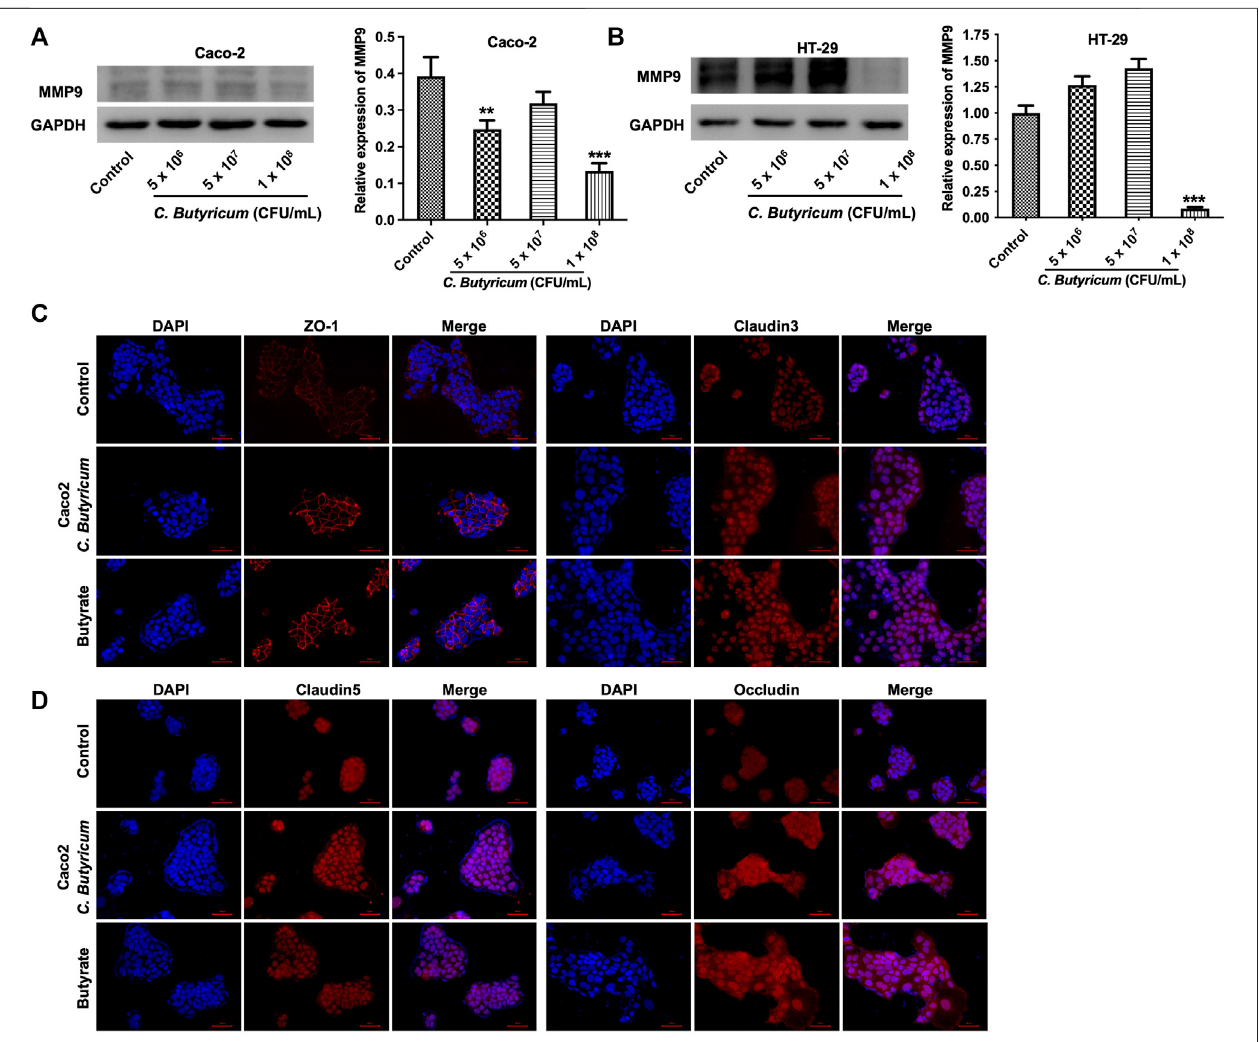
FIGURE 2 | Clostridium butyricum or butyrate treatment reduced MMP9 expression in Caco-2 and HT-29 cells. (A) The Caco-2 and (B) HT-29 cells were co- cultured with (C) butyricum (5 × 10 6 , 5 × 10 7 , or 1 × 10 8 CFU/ml) for 6 h in an anaerobic environment. After that, the supernatant was removed, and cells were then cultured in normoxia environment for 48 h. Western blot assay was used to determine the expression of MMP9 in cells. (C,D) Caco-2 cells were treated with 2 mM butyrate for 48 h. Meanwhile, cells were co-cultured with C. butyricum (1 × 10 8 CFU/ml) for 6 h in an anaerobic environment. After that, the supernatant was removed,and cellswerethencultured innormoxiaenvironment for48 h.IFassaywasusedtodetermine theexpressions ofZO-1, Claudin3, Claudin5, Occludinincells. ** p < 0.01, *** p < 0.001 vs. control group. MMP9, matrix metallopeptidase 9; ZO-1, Zona occludens 1.